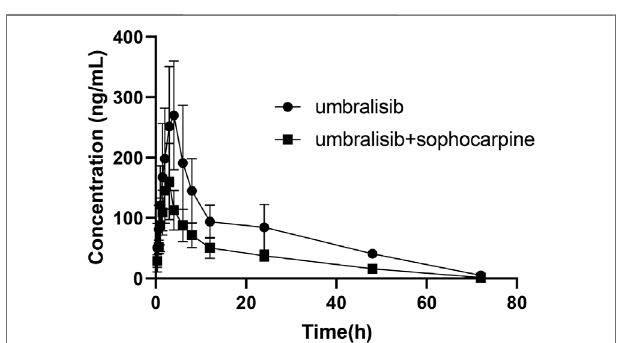
FIGURE3| Meanplasmaconcentration-timecurvesofumbralisibinrats after oral administration of umbralisib with or without sophocarpine ( n (cid:1) 6).